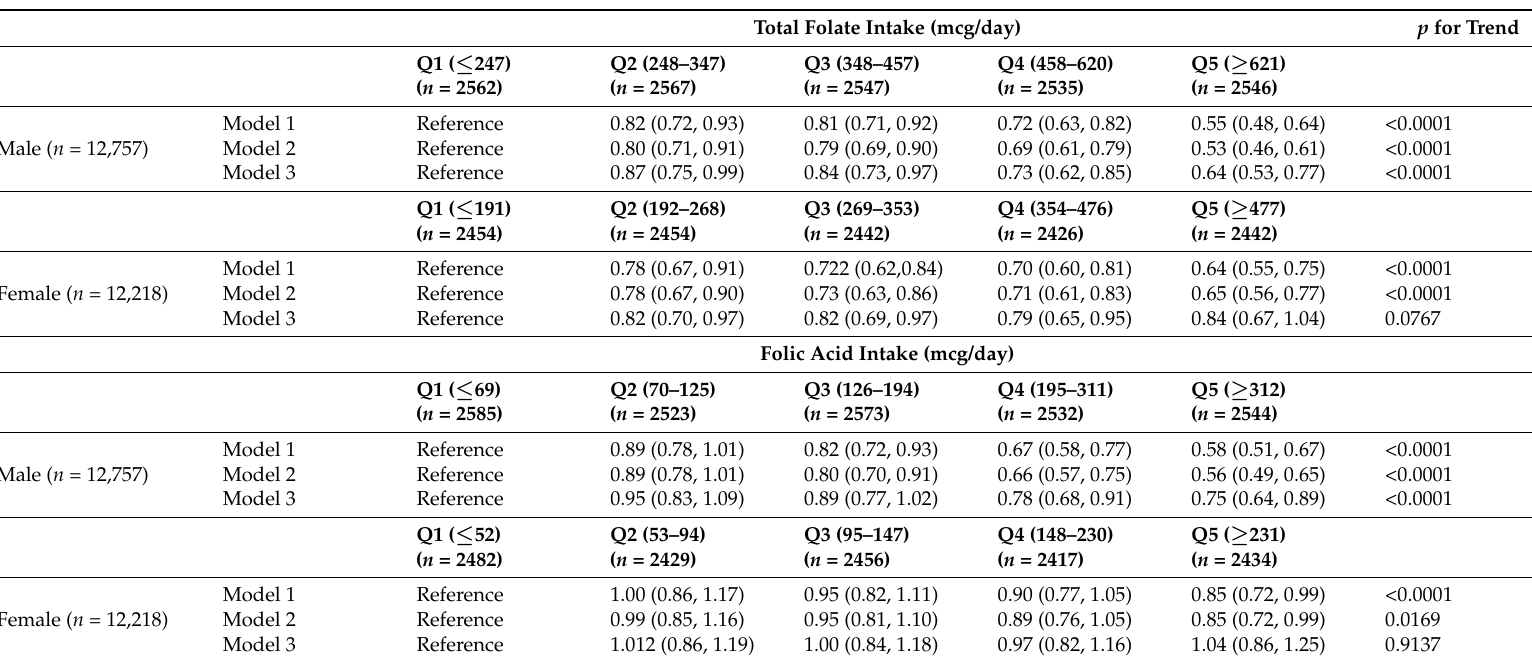
Table 4. Adjusted odds ratios of HU among participants associated with folate